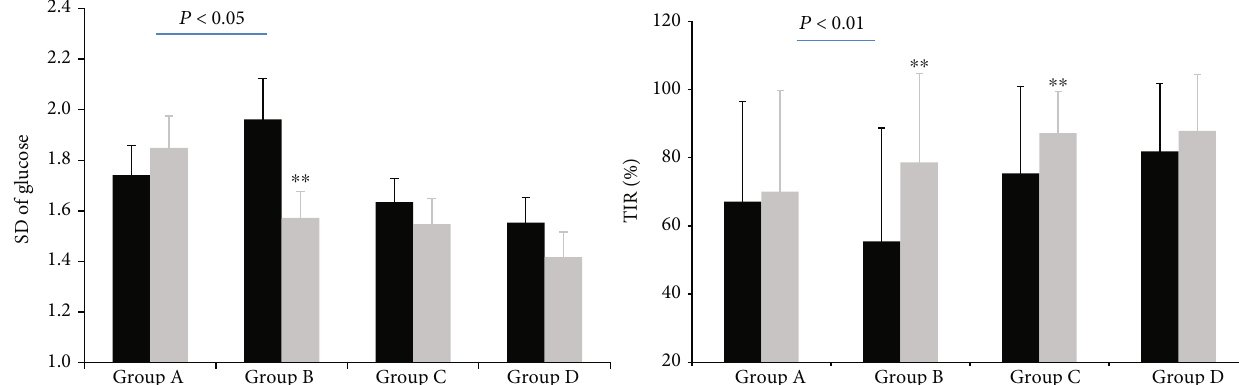
Figure 4: Comparison of standard deviation of glucose and time in range between pre-and post-test. SD: standard deviation; TIR: time in range. ∗ post-test vs. pre-test, P < 0.05, ∗∗ post-test vs. pre-test, P < 0.01. The improvement of SD showed signi fi cant di ff erence between control group and Jinlida group (P < 0.05). The change of TIR was found signi fi cant di ff erence between control group and Jinlida group (P <